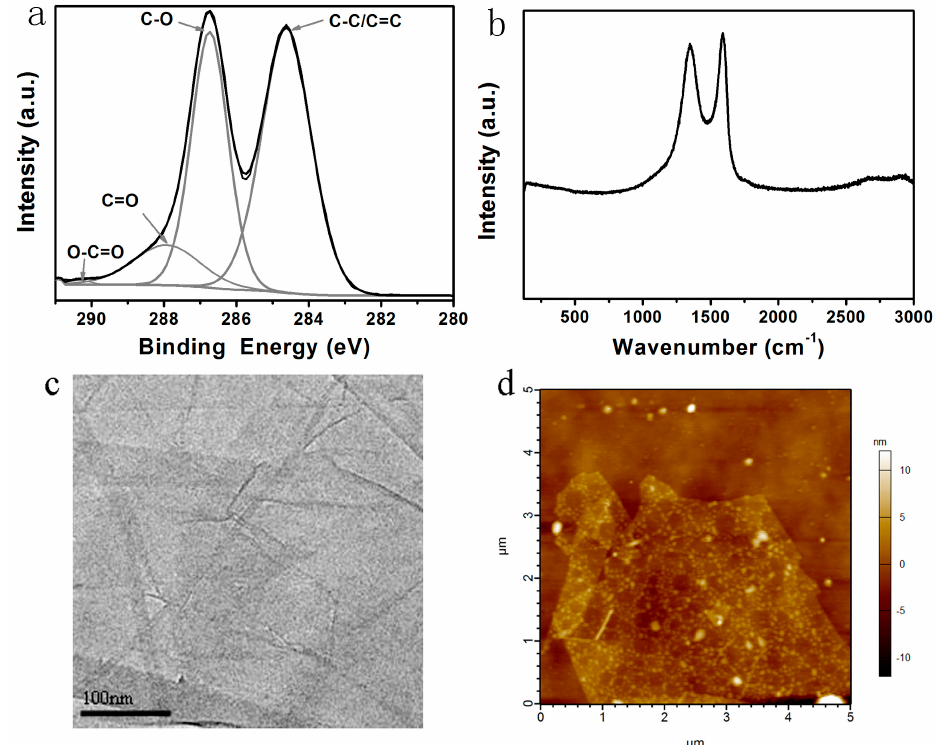
Figure 1. Characterization of graphene oxide (GO). ( a ) X-ray photoelectron spectroscopy (XPS) of GO film; ( b ) Raman spectrum of GO film; ( c ) transmission electron microscopy (TEM) of GO; ( d ) atomic force microscopy (AFM) of GO.